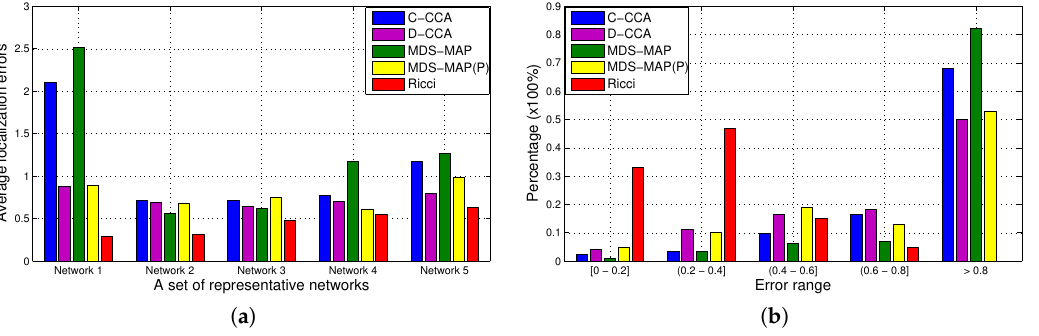
Figure 9. ( a ) Comparison of the average localization errors of different methods on the networks